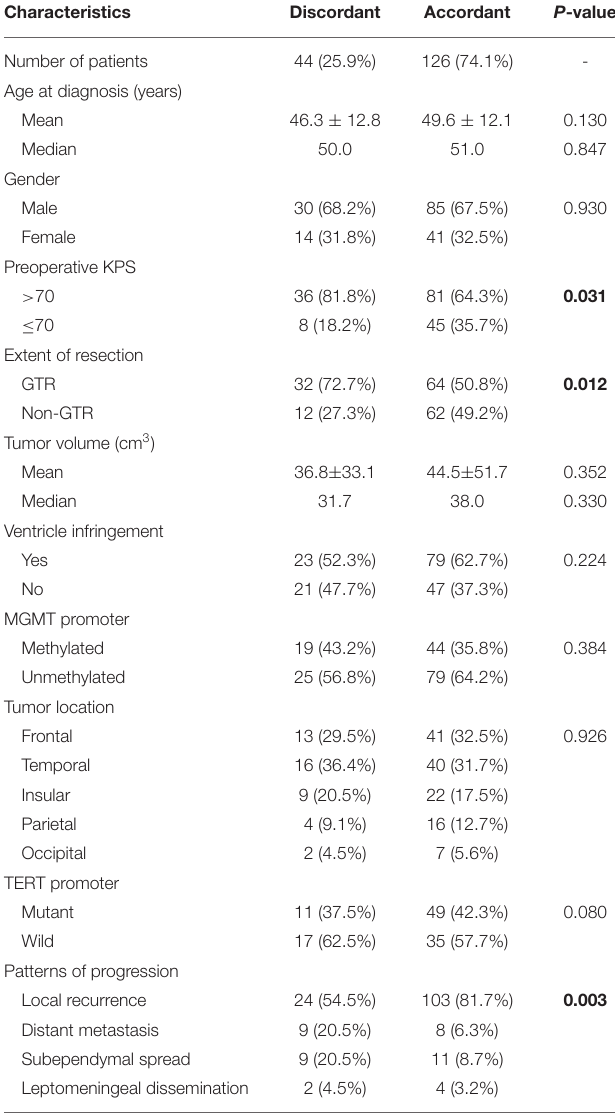
TABLE 1 | Clinical, demographic and radiological characteristics of patients with/without discordant T2/FLAIR T1CE images.